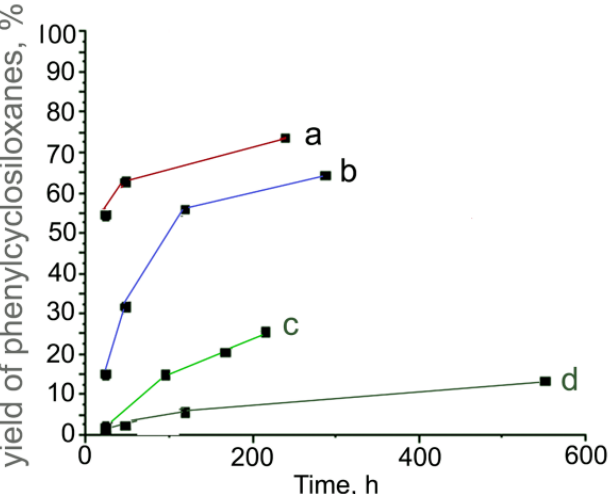
Figure 2. Dependence of the yields of phenylcyclosiloxanes from the hydrolysis–condensation reaction of 1 on time at different concentrations of C HCl in water-acetone solutions: C HCl = 0.26 ( a ); 0.15 ( b ); 0.055 ( c ), and 0.032 mol L − 1 ( d ).